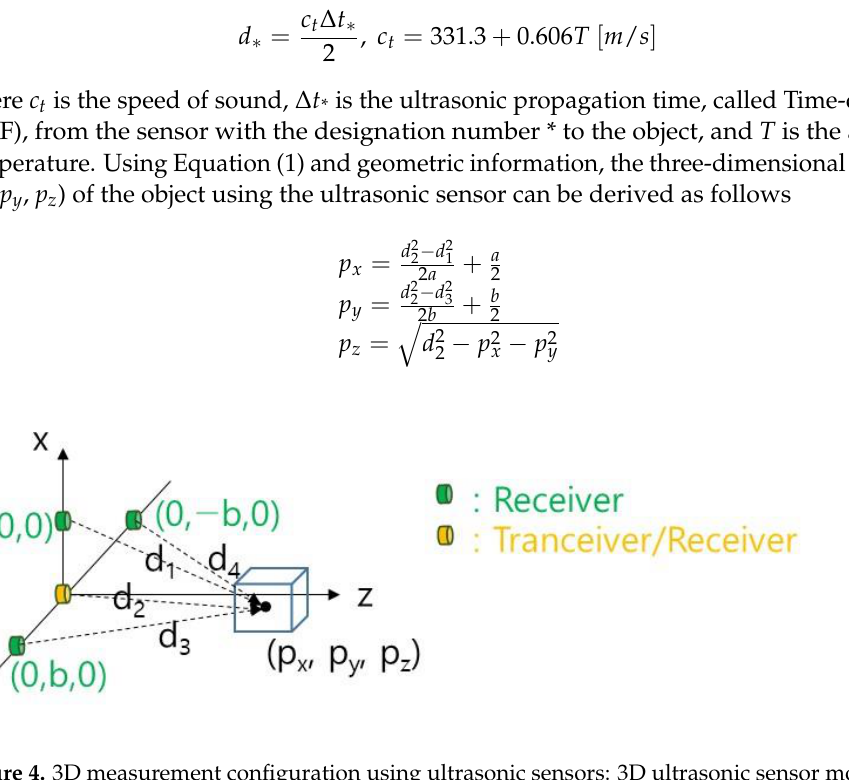
Figure 4. 3D measurement configuration using ultrasonic sensors: 3D ultrasonic sensor module.